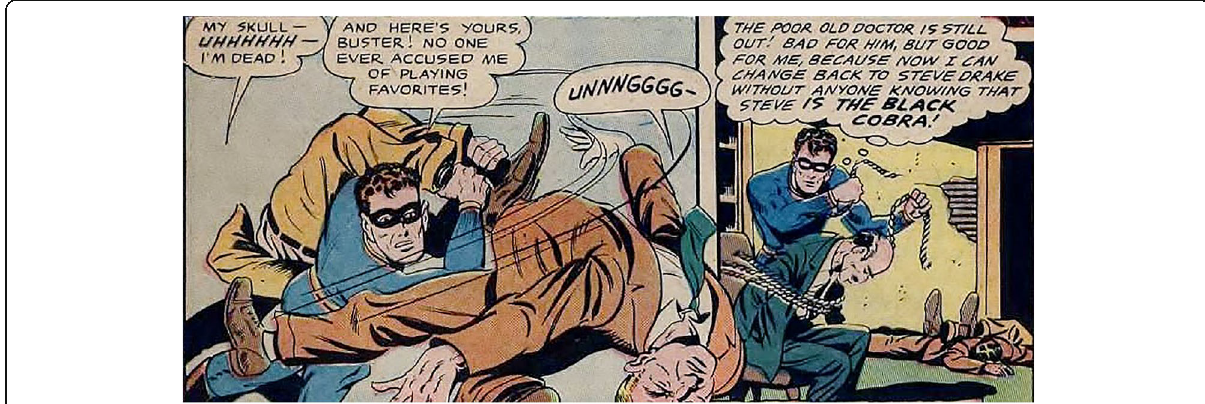
Fig. 2 Two panels from the graphic story Black Cobra (1954). In these panels, the bodily positions in the second panel convey that a change in goals has occurred (i.e., the Black Cobra is rescuing the doctor rather than fighting his enemies). Available from